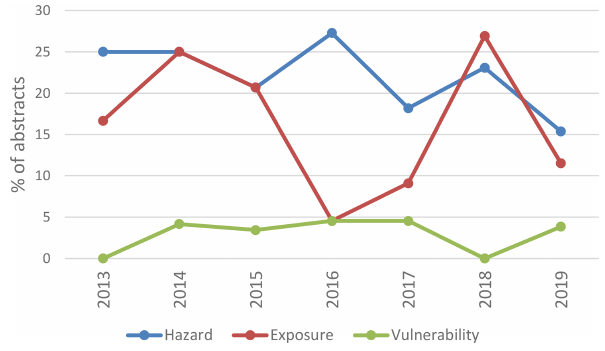
Figure 1. Percentage of abstracts accepted and presented at the EGU session “Global and continental scale risk assessment for nat- ural hazards: methods and practice” that explicitly mention exam- ining future projections of risk based on future scenarios of hazard, exposure, or vulnerability